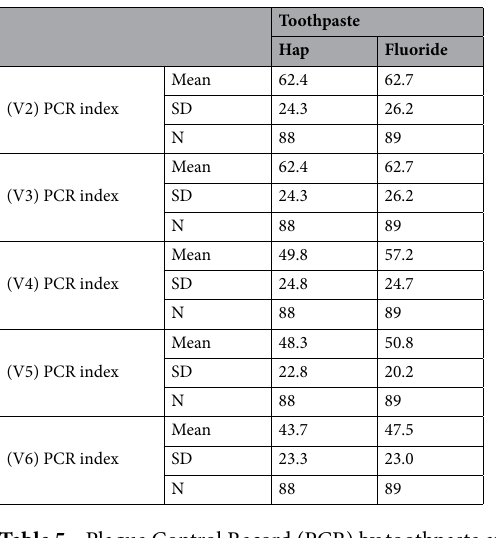
Table 5. Plaque Control Record (PCR) by toothpaste at visit 2 (baseline) to visit 6. SD standard deviation